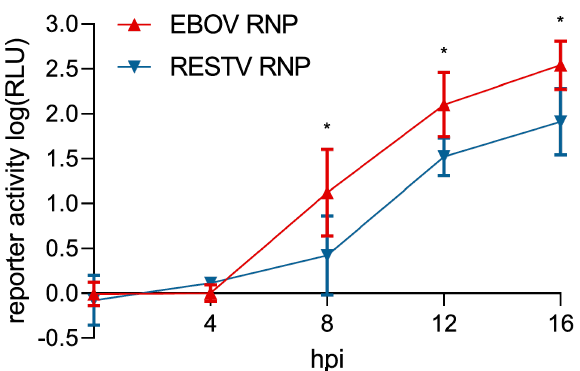
Figure 5. Comparison of e ffi ciencies of EBOV and RESTV RNA synthesis using optimized RNP concentrations. Cells were pre-transfected with optimized amounts of either EBOV (red) or RESTV (blue) RNP protein-expressing plasmids, as determined in Figure 4, and infected with EBOV trVLPs. At the depicted time points, target cells were lysed, and the luciferase activity was measured. As negative controls, the expression plasmid for EBOV L was replaced by an empty vector, and the background values were subtracted from the data. Means and standard deviations of 4 independent experiments are shown. *: p < 0.5.